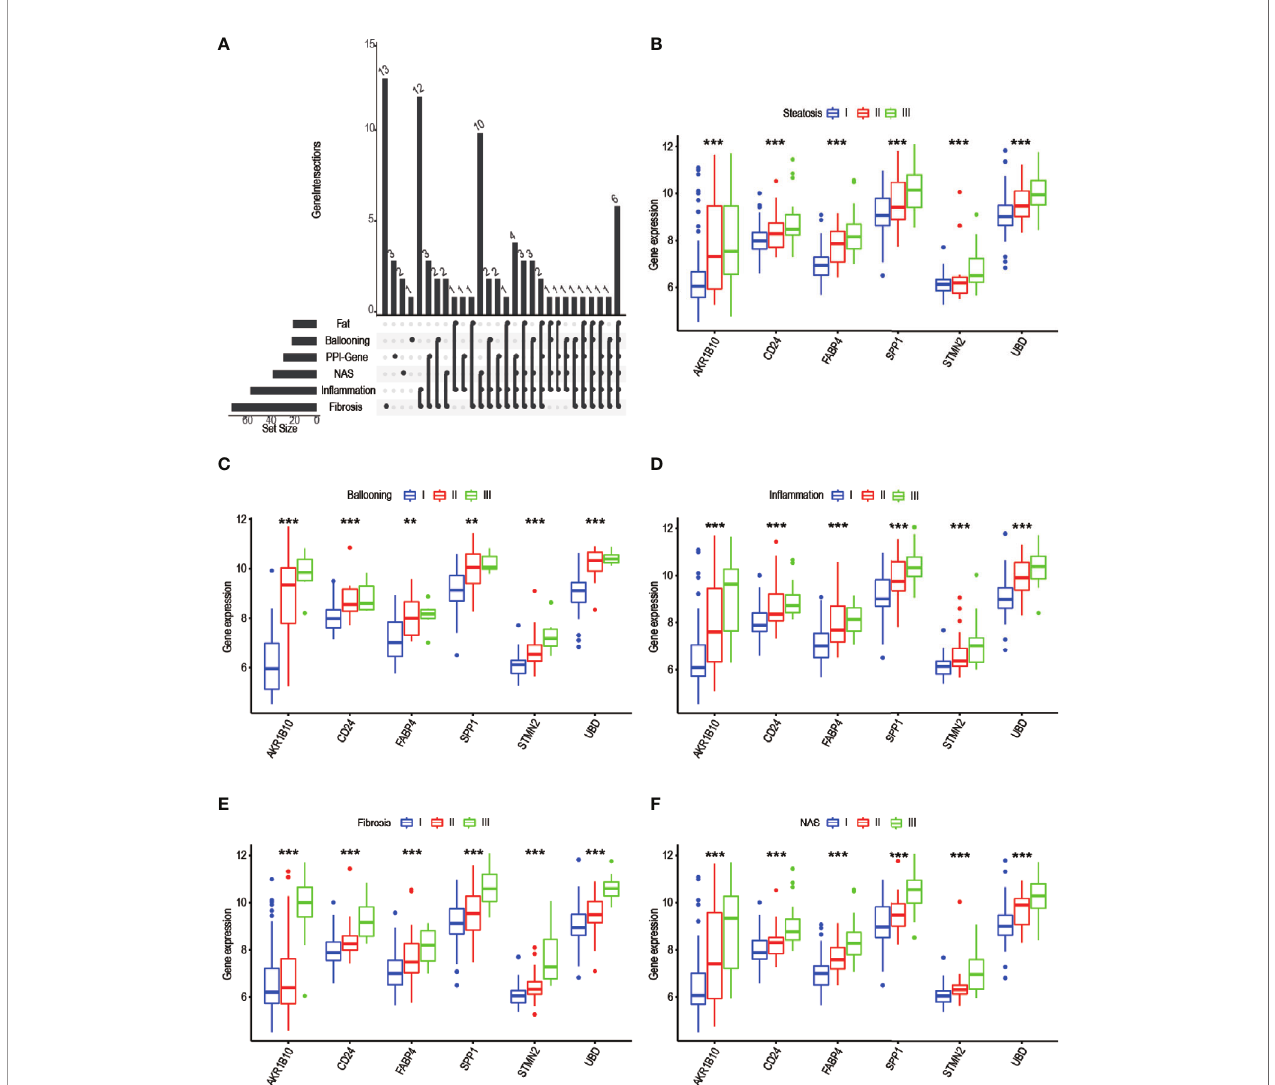
FIGURE 7 | Screening of progress-related genes. (A) UpSet plot including trait related genes and PPI-related genes; (B-F) 6 progress-related genes ’ expression in different degree of steatosis (B) , ballooning (C) , in fl ammation (D) , fi brosis (E) , NAS (F) . (* P< 0.05, ** P< 0.01, *** P<